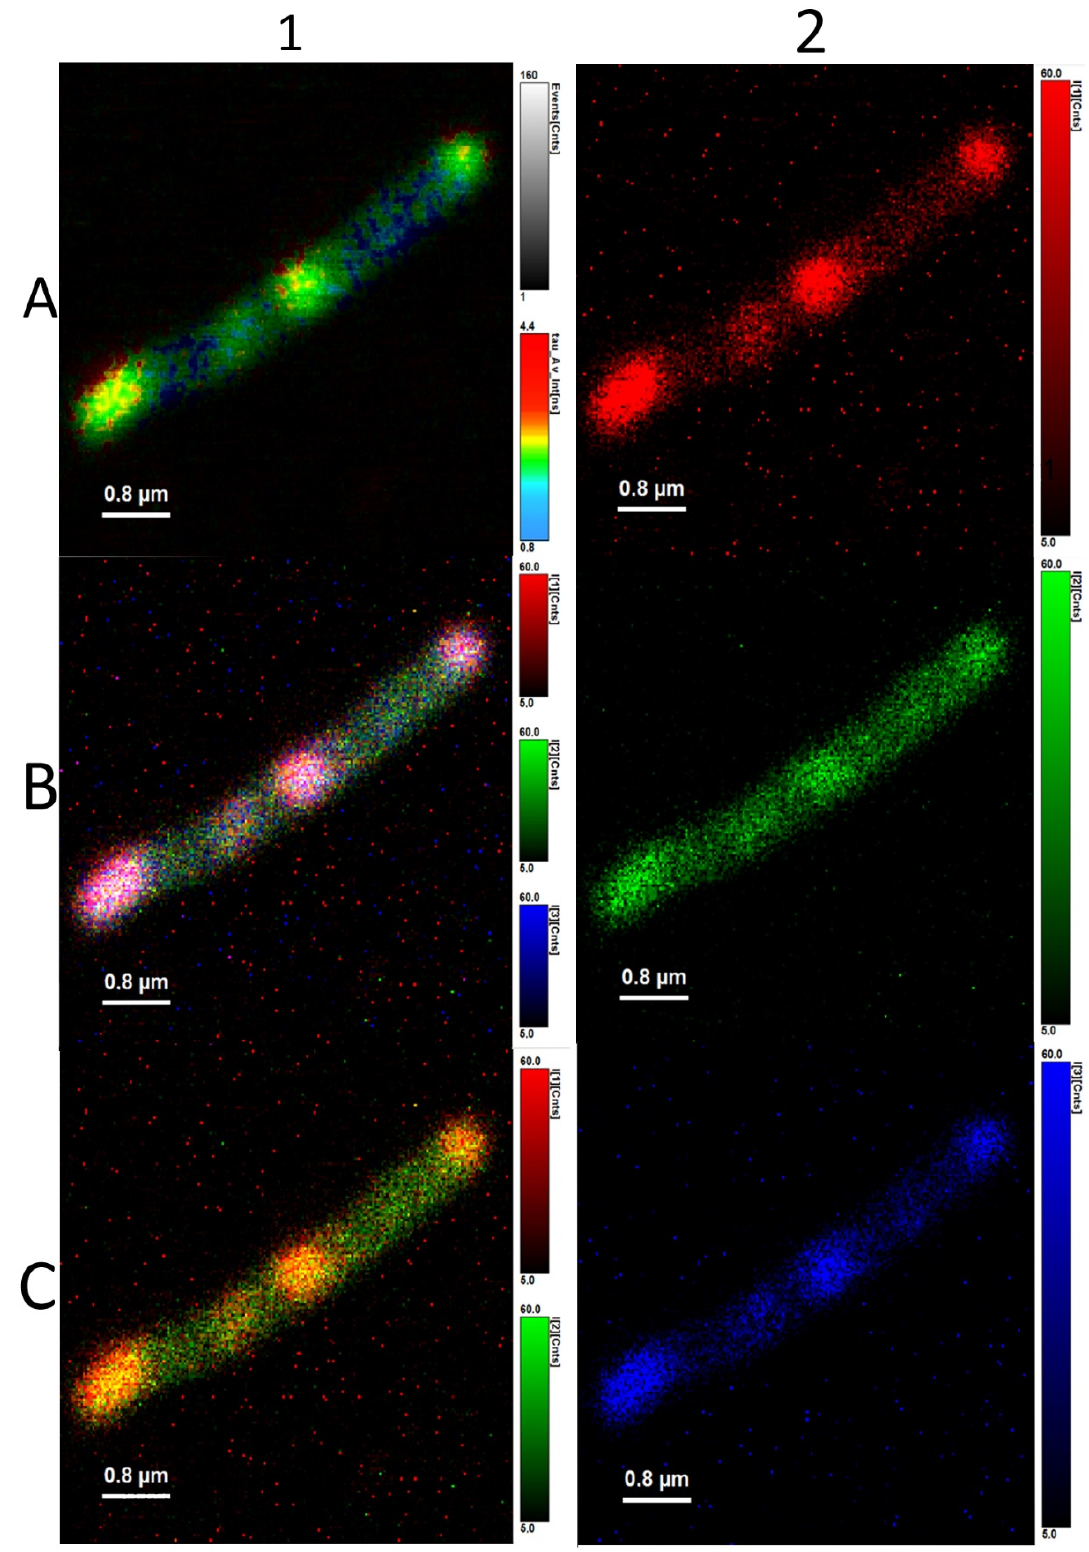
Figure 8. Cupriavidus necator PHB-4. Autofluorescence ( 1A ), all three lifetimes of fluorescence of flavins observed are combined in one picture ( 1B ), two average fluorescence lifetimes of flavins found ( 1C ). The three different fluorescence lifetimes are imagined separately: 4.330 ± 0.062 ns ( 2A ), 1.180 ± 0.029 ns ( 2B ), and 0.00773 ± 0.00062 ns ( 2C ). Figure 9 C. necator H16 and Figure 10 C. necator PHB-4 show cells non-stained (left) and stained with BODIPY 493/503 (right). Expectedly, the intensity of fluorescence of the stained samples is higher than that of non-stained, but what is interesting is the fact that the intensity values of the shorter average lifetime, τ 1 , rose only slightly.